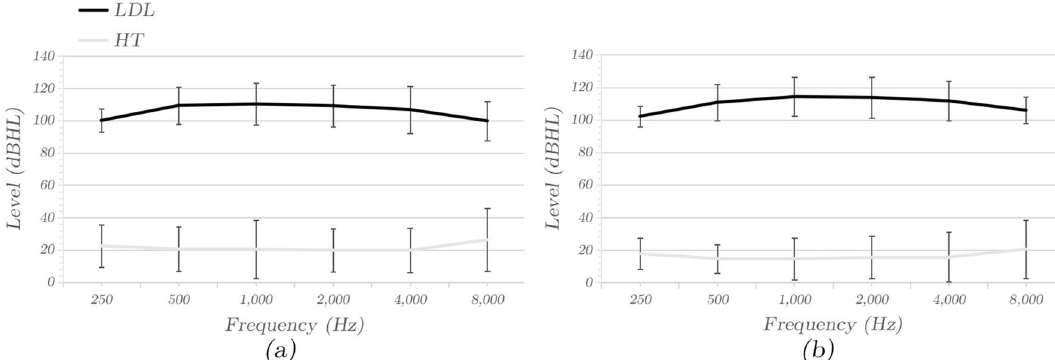
Figure 1. Hearing thresholds (HTs) and loudness discomfort levels (LDLs). ( a ) Average HTs (gray) and LDLs (black) of the hyperacusis group. Error bars denote ± 1 SD. ( b ) Average HTs (gray) and LDLs (black) of the normal group. Error bars denote ± 1 SD.